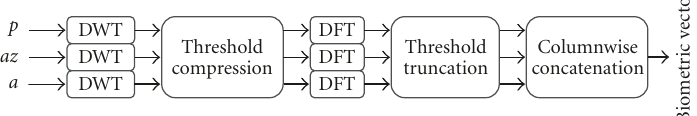
Figure 2: DWT-DFT feature